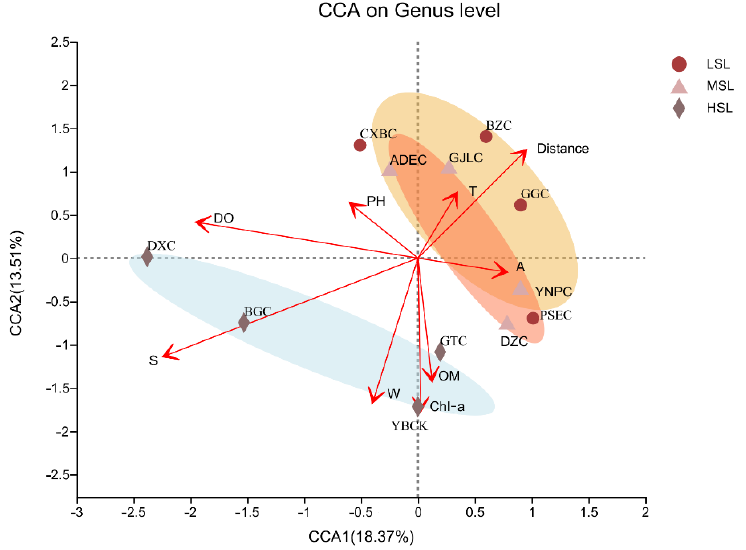
Figure 8. Canonical correspondence analysis (CCA) of microbial community composition and physicochemical characteristics of the sampled lakes on the Tibetan Plateau, China.